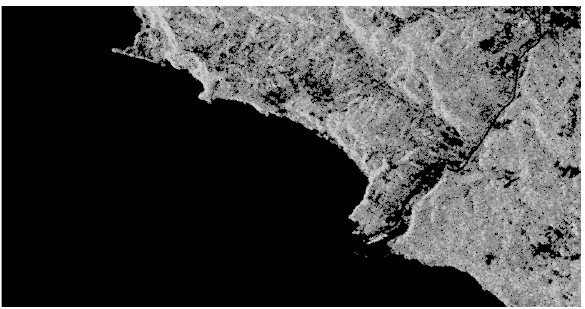
Figure 6. Mathematical morphology opening applied image.